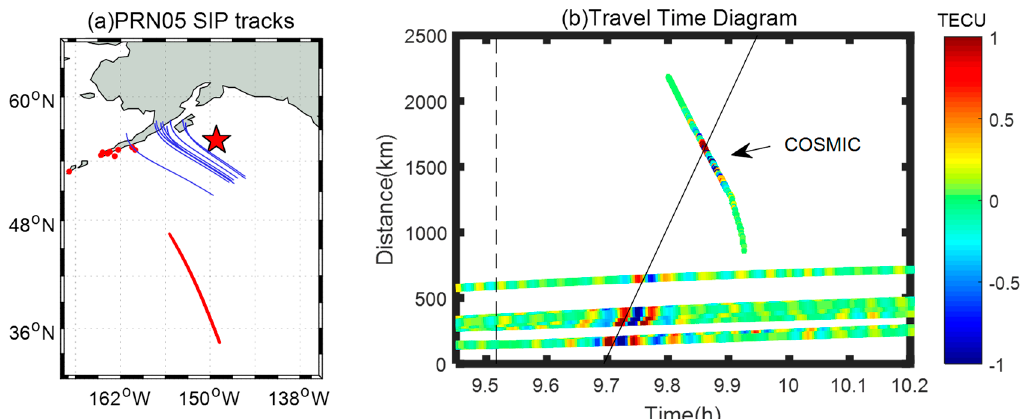
Figure 10. The results of the combination of COSMIC radio occultation and observations of ground-based GPS stations. ( a ) shows the puncture point trajectory of several GPS stations and the ground projection of radio occultation observations. ( b ) combines the normalized filtered TEC series with the detrended COSMIC electron density perturbation and the diagonal line is used to fit the speed of the TEC disturbances.